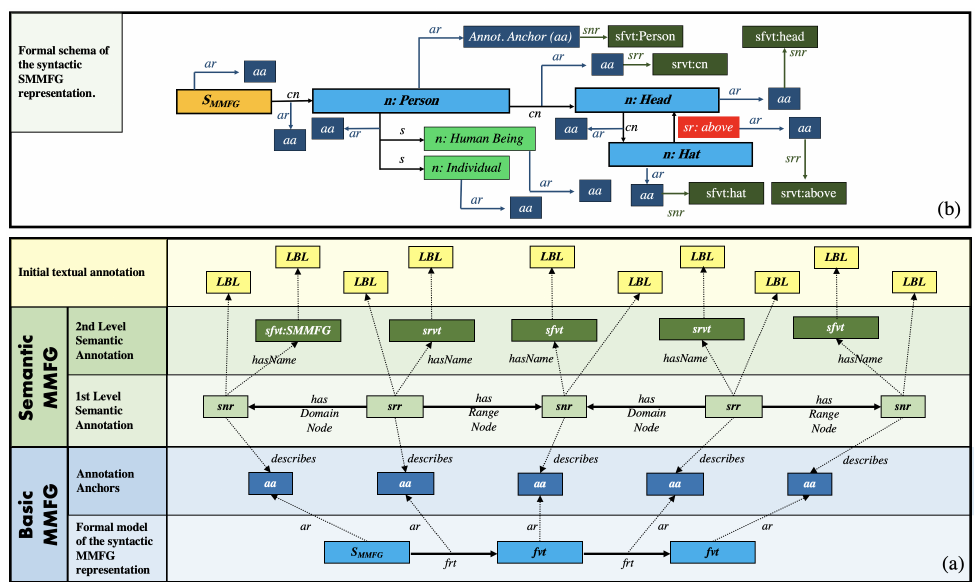
Figure 5. SMMFG overview: ( a ) formal model of the syntactic SMMFG; ( b ) formal syntactic schema of the SMMFG representation SMMFG Ex